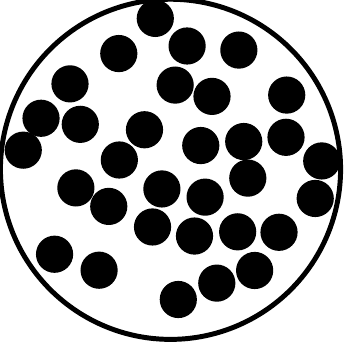
Figure 3. An example SAMI-U array layout. Ideally the layout should be maximally random in order to maximise the number of independent baselines and thus give the maximum amount of unique information in Fourier space. This is a random antenna arrangement with the lowest sidelobe level from a set of 10 , 000 candidate arrangements. The computational expense of optimis- ing the placement of the 32 elements is likely to be prohibitive.